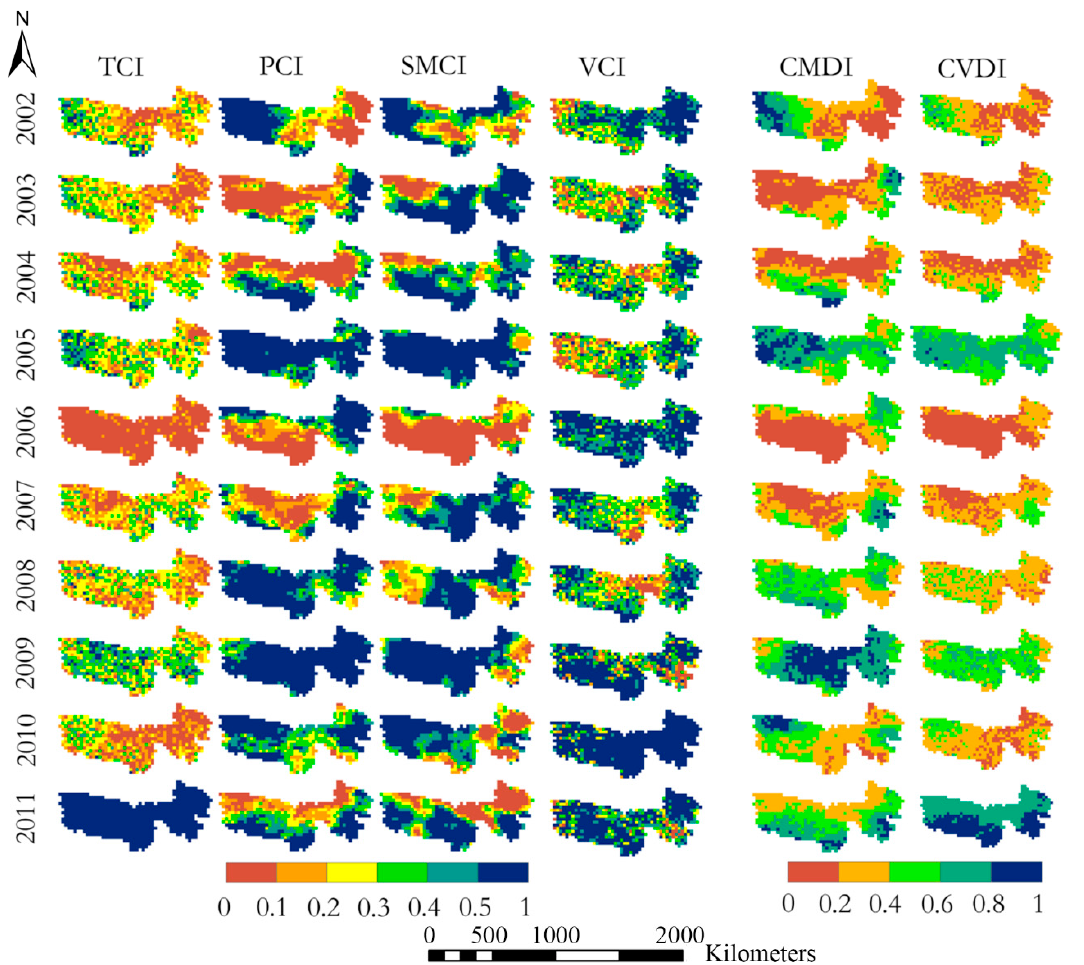
Figure 4. Spatial distribution of drought monitored by CI-based drought indices in July from 2002 to 2011.